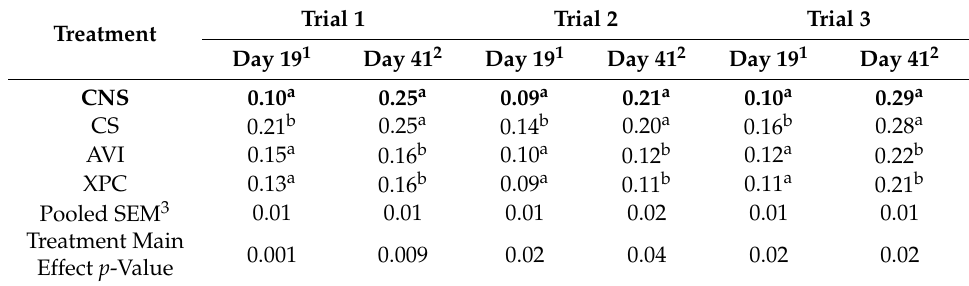
Table 2. Heterophil/lymphocyte ratios after an acute stress challenge (day 19) and after 41 days of growth.